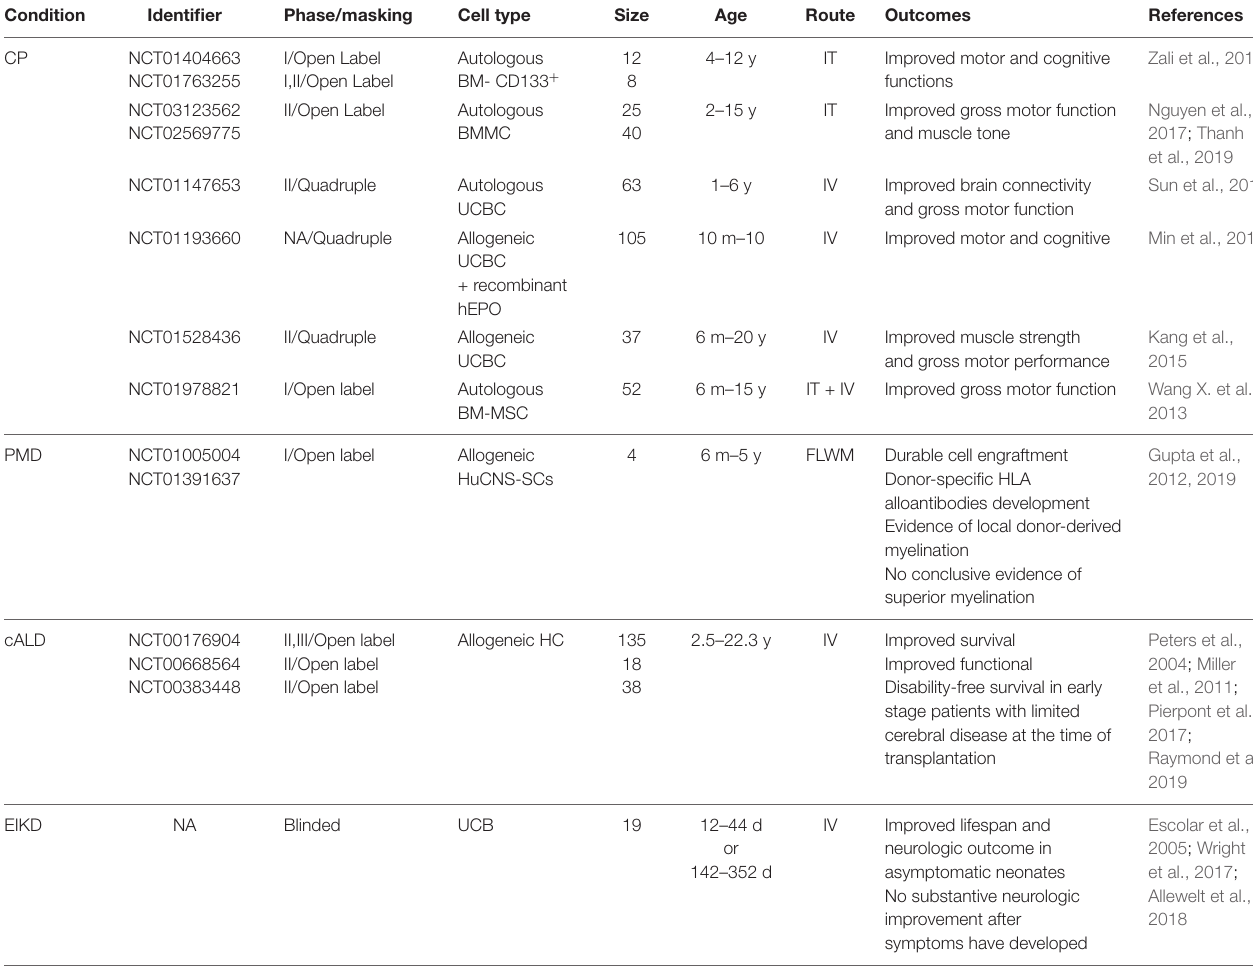
TABLE 2 | Clinical trials of cells therapy for infants and children with CP and childhood leukodystrophies.